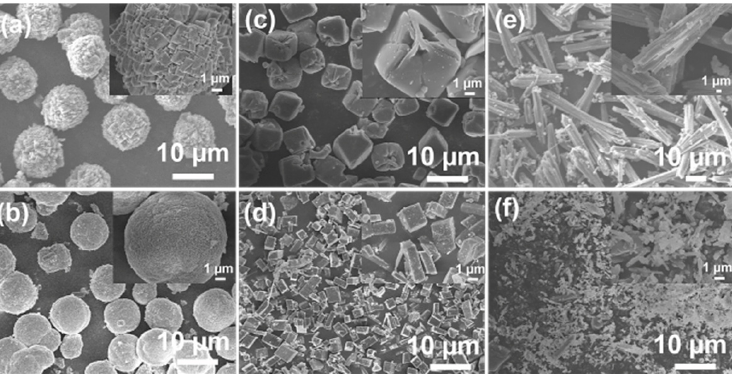
Figure 6. SEM images of samples synthesized with different ILs (( a ) for S-EM-C, ( b ) for S-EM-B, ( c ) for S-BM-C, ( d ) for S-BM-B, ( e ) for S-EMM-B, ( f ) for S-BMM-B). The solid-state 13 C nuclear magnetic resonance (NMR) spectra of sample S-EM-C were molecular sieves. As we can see in Figure 7, peaks at 132 ppm and 125 ppm belong to the carbon atoms on the imidazole ring of the ionic liquid. The two peaks of the N-C-C-N bond in [EMIm]Cl overlap into one peak (125 ppm) in the solid 13 C NMR spectrum. The 39 ppm peak belongs to the substituted methyl group on the imidazole ring [23]. Peaks at 11 ppm and 44 ppm are attributed to substituted ethyl groups on the imidazole ring, which indicates that [EMIm]Cl exists in the framework structure of the molecular sieve.